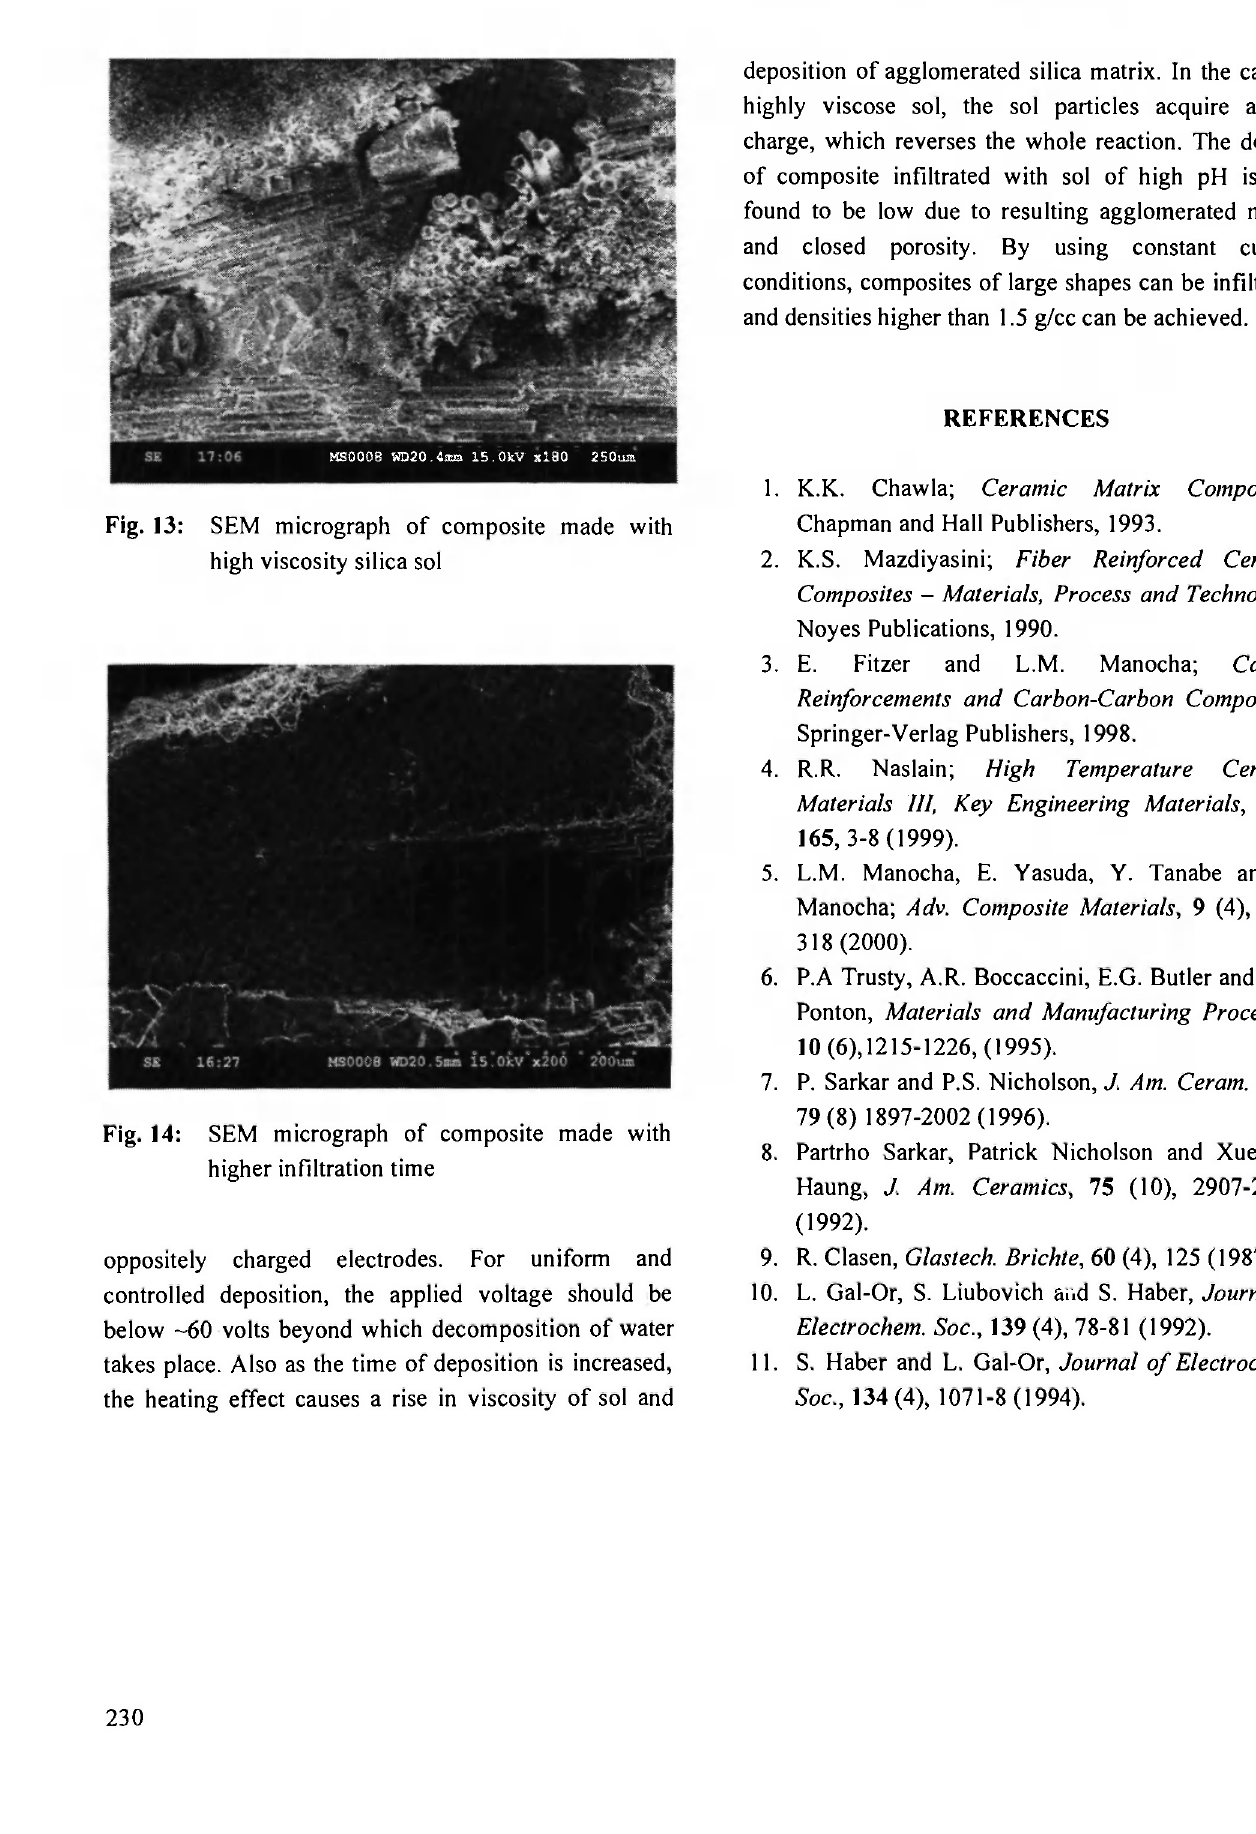
SEM micrograph of composite made with high viscosity silica sol